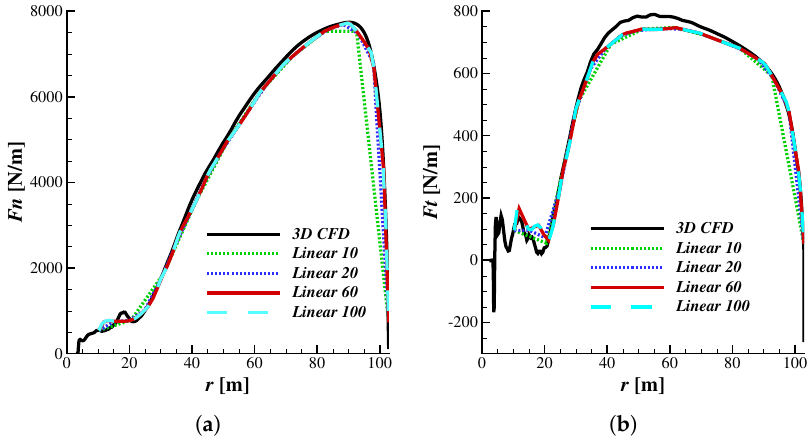
Figure 13. Effects of blade element discretization for radial-linear interpolation on the sectional force distributions along the blade radius; ( a ) normal force, ( b ) tangential force.